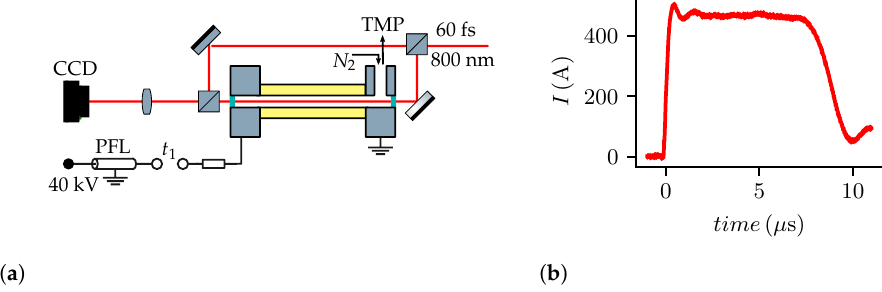
Figure 1. Schema of the experiment ( a ) and measured pre-ionization current ( b ).